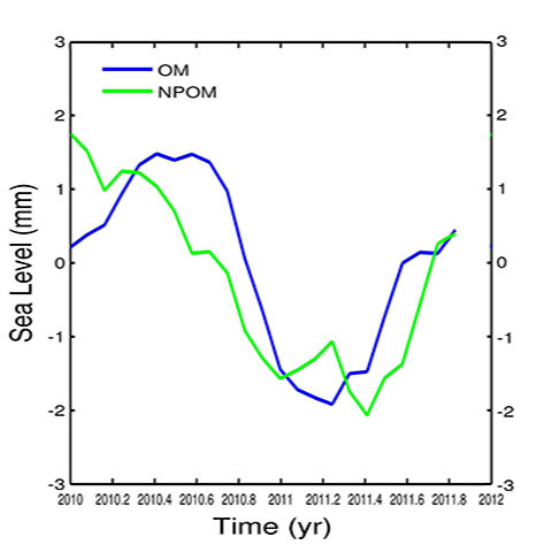
Fig. 5. Interannual global mean ocean mass from GRACE (dark blue curve) and north Pacific ocean mass (also estimated from GRACE) (green curve) during the 2011 La Niña.